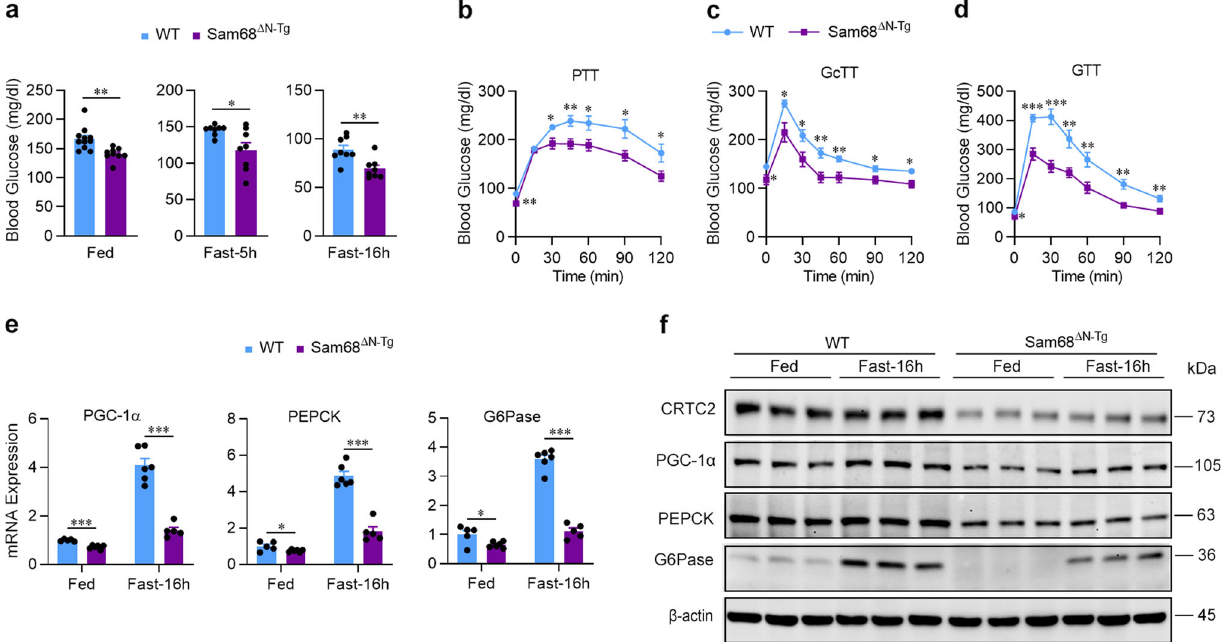
Fig. 5 Blood glucose levels and gluconeogenic gene expression are lower in mice carrying an N-terminal deletion ( Δ N) of Sam68 than in WT mice. Blood glucose levels were measured in Sam68 Δ N-Tg and their WT littermates ( a ) under feeding conditions (WT, n = 14; Sam68 Δ N-Tg , n = 9) and after fasting for 5 h or 16 h (WT, n = 8; Sam68 Δ N-Tg , n = 8), and in the ( b ) pyruvate tolerance test (PTT; WT, n = 8; Sam68 Δ N-Tg , n = 8), ( c ) glucagon tolerance test (GcTT; WT, n = 8; Sam68 Δ N-Tg , n = 8), and ( d ) glucose tolerance test (GTT; WT, n = 9; Sam68 Δ N-Tg , n = 8). Sam68 Δ N-Tg and WT mice were sacri fi ced under feeding conditions or after fasting for 16 h; then, ( e ) mRNA and ( f ) protein expression of gluconeogenic genes, and protein levels of CRTC2, were evaluated in liver tissues ( e ; Fed: WT, n = 5; Sam68 Δ N-Tg , n = 6. Fast-16 h: WT, n = 6; Sam68 Δ N-Tg , n = 5. f ; n = 3). Data are expressed as mean ± s.e.m. * p < 0.05, ** p < 0.01, *** p < 0.001 versus WT mice under the same condition and at the same time point ( a : unpaired two-tailed t- test; b – e : two-way ANOVA). Source data are provided as a Source Data fi